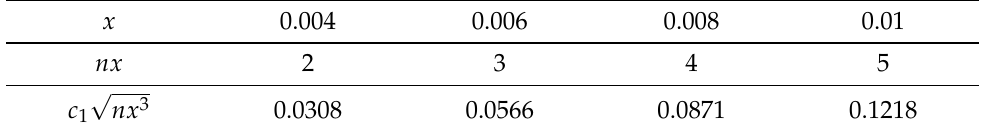
Table 1. Values of the function c 1 √ nx 3 for n = 500, p = 0.002, x = kp , k =